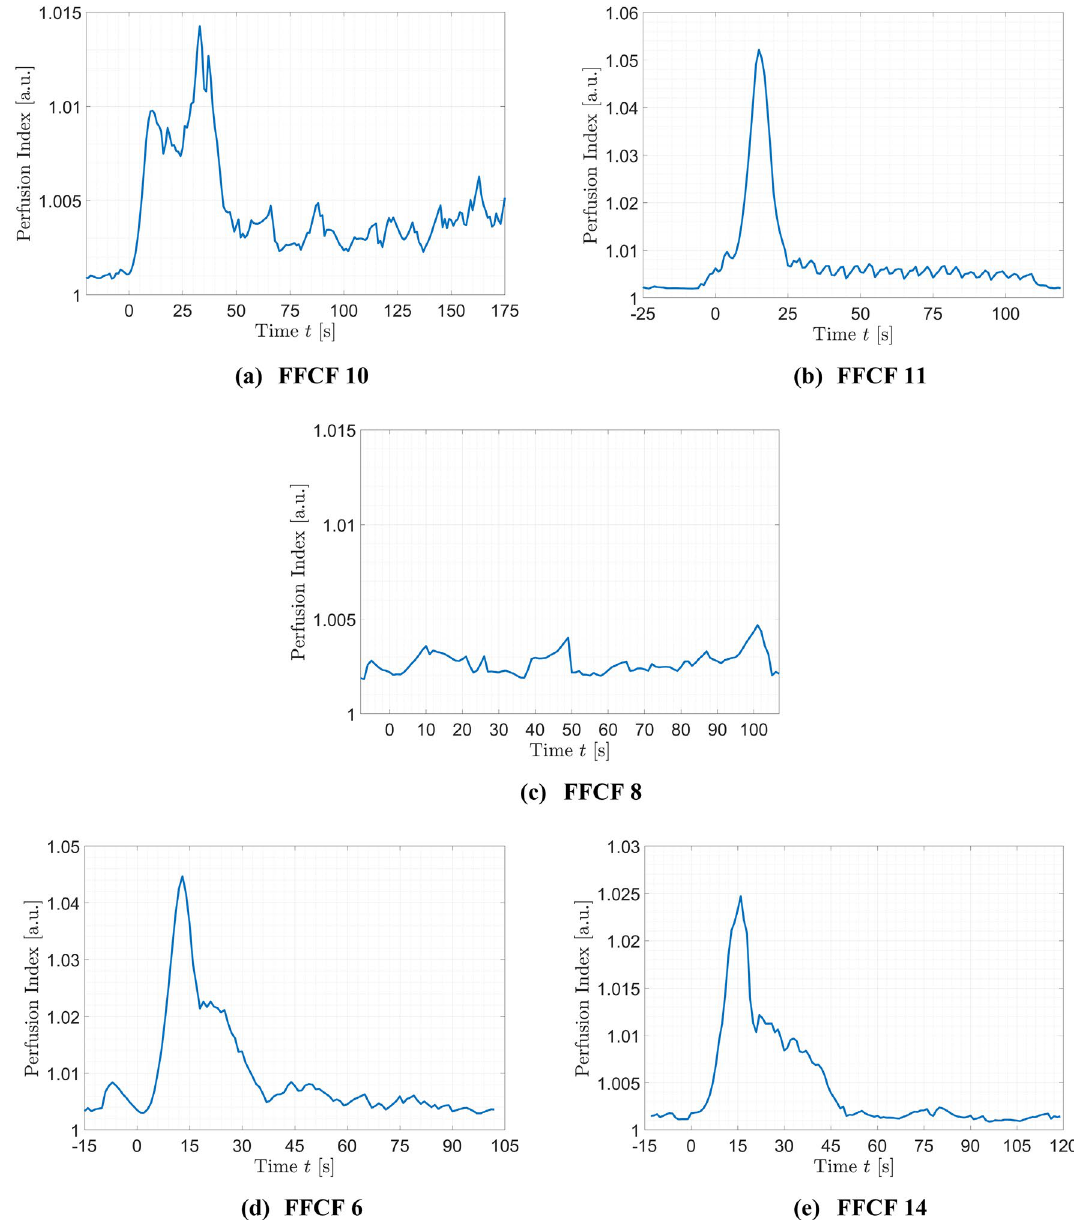
Figure 5. Perfusion index PI of selected cases. The documented reperfusion was set to t = 0 s. ( a ) #10 and ( b ) #11 were successful, incident-free reperfusions showing a PI peak. ( c ) Failed flap (#8) showed no PI peak. ( d ) #6 and ( e ) #14 showed the expected PI peak although vasospasms occurred after